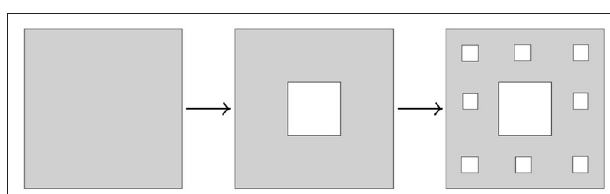
FIGURE 16 | Construction of Sierpinski